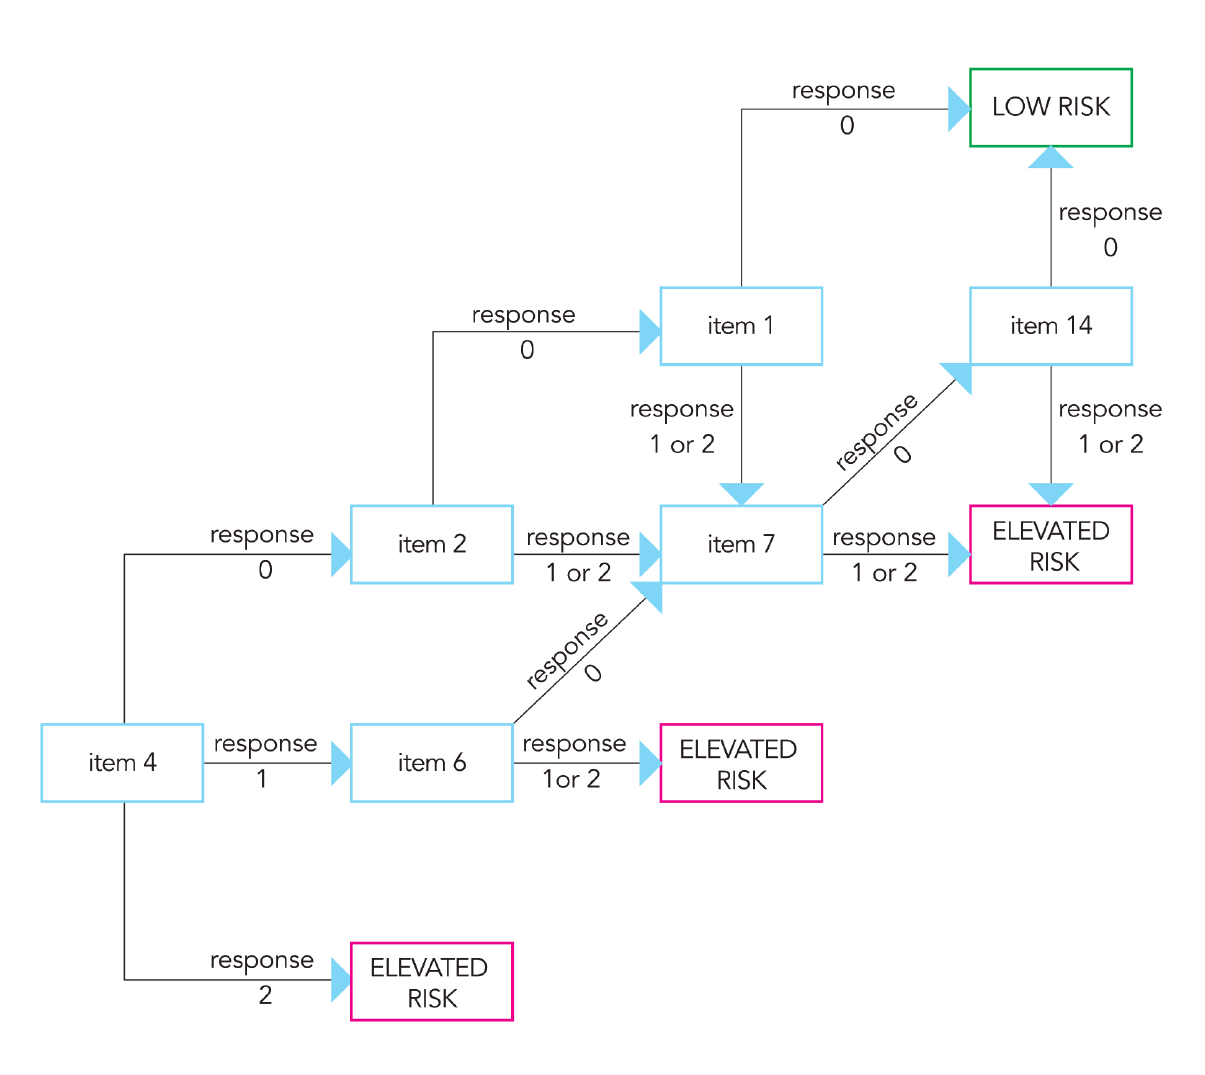
Figure 3. Concrete example of a result of a CAT